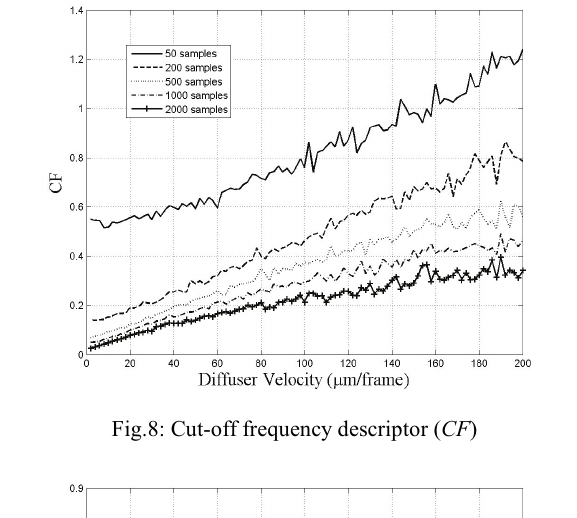
Fig. 6 High-Low Ratio descriptor ( HLR )